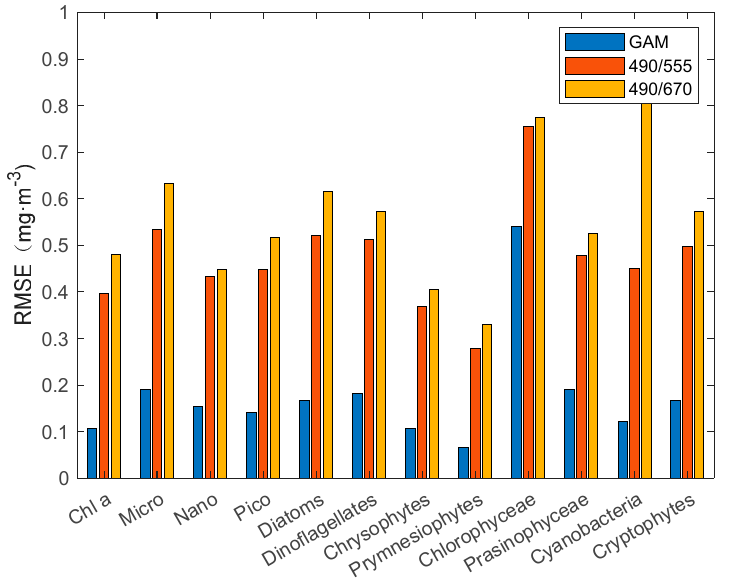
Figure 4. R 2 comparison diagram of the GAM and third-order polynomial algorithm.